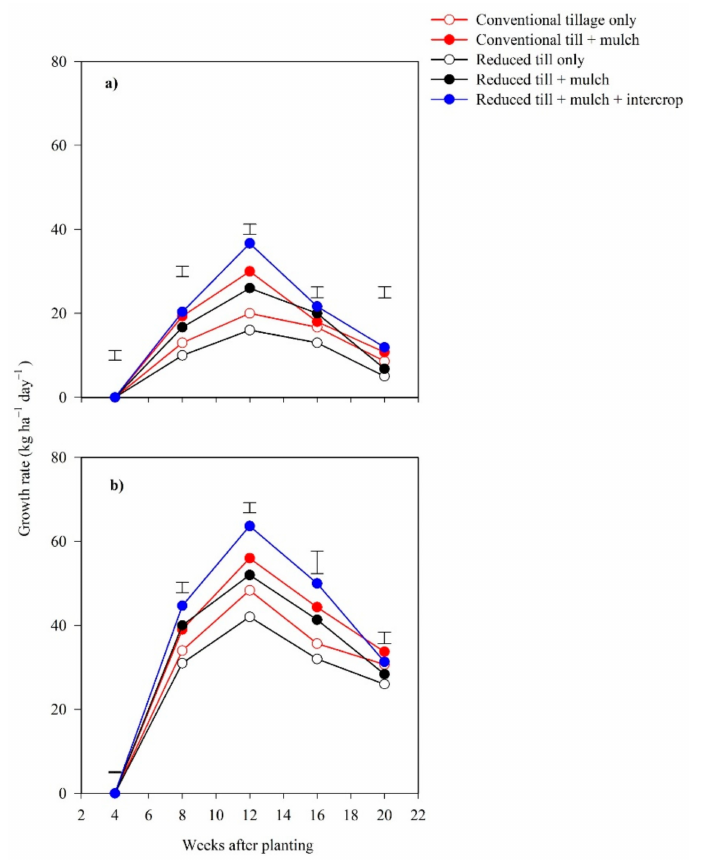
Figure 5. Finger millet growth rate with conventional tillage only (control), conventional tillage + mulch (partial CA1), reduced tillage only (partial CA2), reduced tillage + mulch (partial CA3) and reduced tillage + mulch + intercropping with cowpea (full CA) treatments during 2015/16 ( a ) and 2016/17 ( b ) cropping seasons. Error bars represent LSD 0.05 .